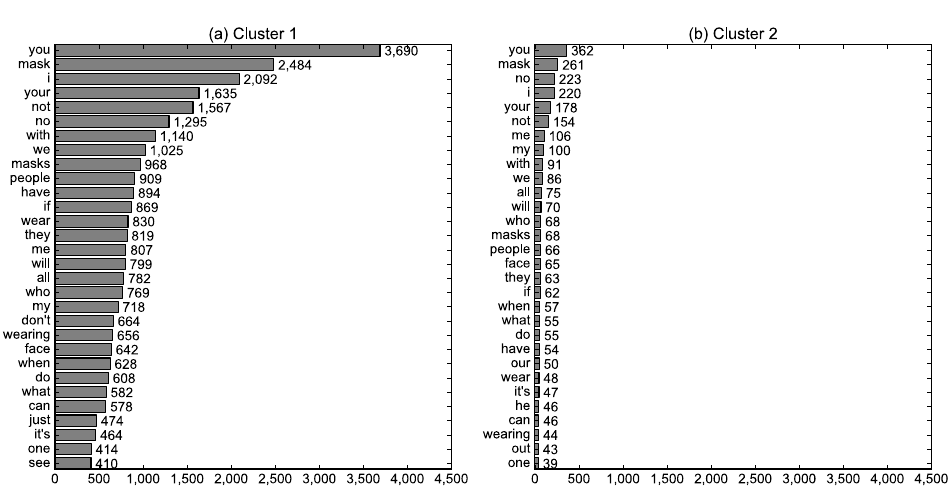
Figure 5. The 30 most frequent words in the Instagram photos with a #NoMask hashtag calculated by cluster.